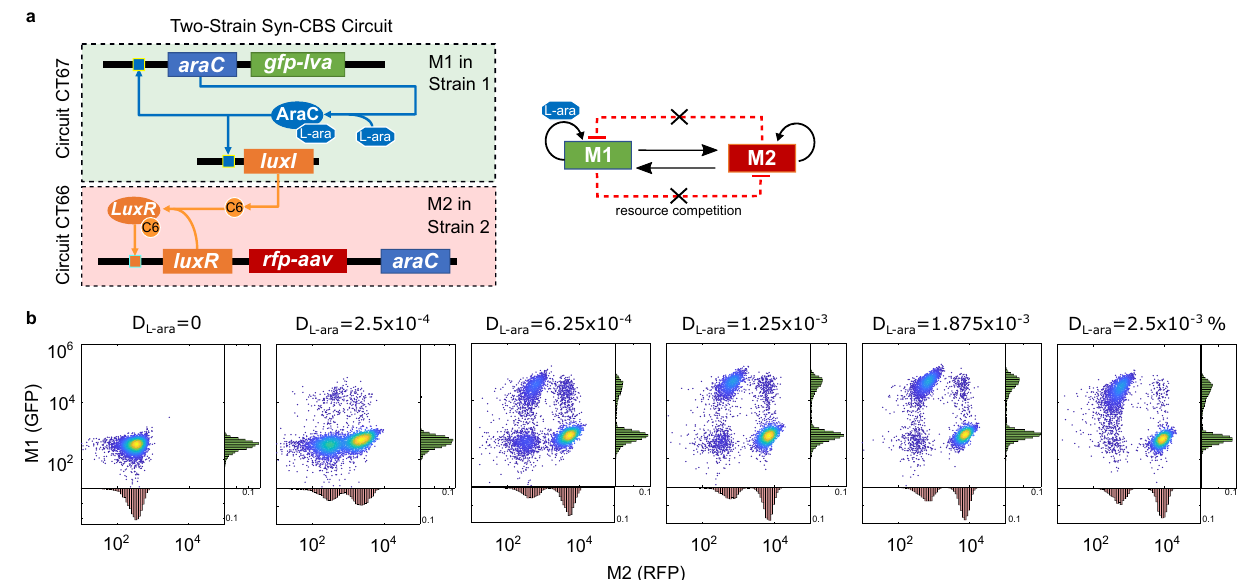
Fig. 5 Minimize resource competition through a division of labor using microbial consortia. a Diagram of two-strain Syn-CBS circuits without a tetR module. b Flow cytometry data show the expected stepwise cell state transitions by increasing the dose of inducer L-ara ( D L-ara ). In total, 10,000 events were recorded for each sample. Data from one representative of three independent biological replicates. Circuits CT66 and CT67 were used here. Source data are provided as a Source Data fi